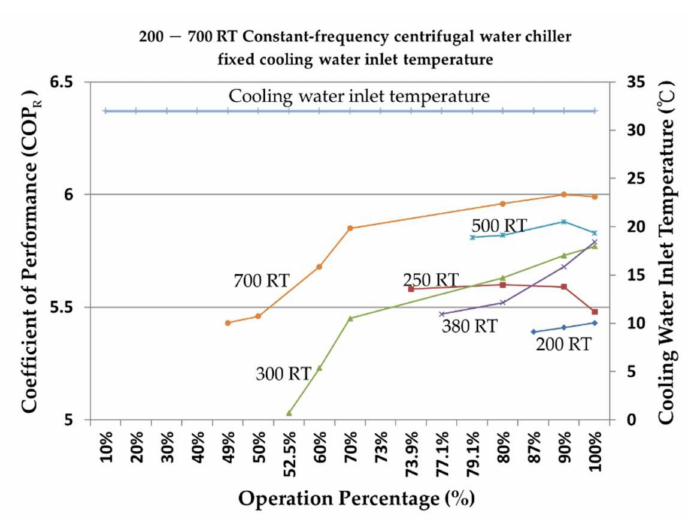
Figure 7. Fixed-cooling water inlet temperature COP R of the 200–700 RT constant-frequency centrifu- gal water chiller.